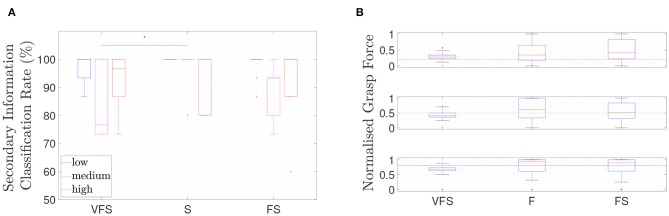
Boxplots of the obtained results of the (A) secondary information classification task, subdivided into the three secondary information classes, and in (B) the achieved grasp force, subdivide into the three target grasp force levels, is shown for 10 subjects. *Asterisk indicates statistical difference by post-hoc analysis p < 0.05.